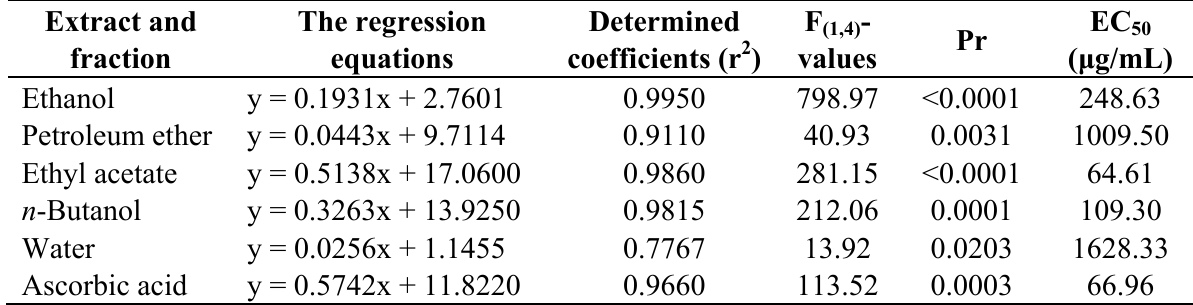
Table 1. The regression equations of the DPPH radical scavenging rate on the sample concentration and the EC 50